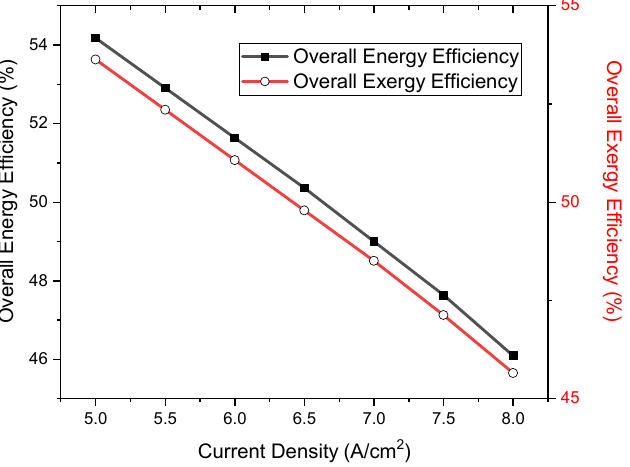
Figure 4. The changes in the overall efficiencies by the variation in the SOFC’s current density.